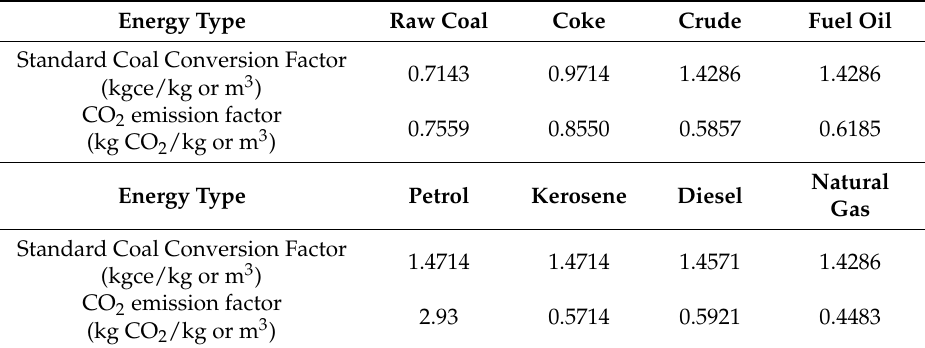
Table 1. Standard coal coefficient and CO 2 emission